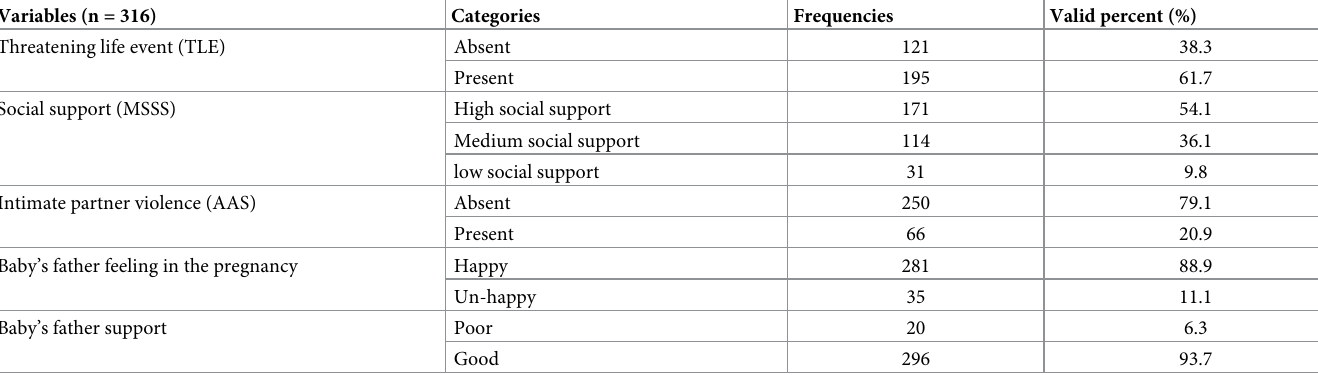
Table 3. Psychosocial factors among pregnant women attending public health facilities in Arba Minch SNNPR Ethiopia